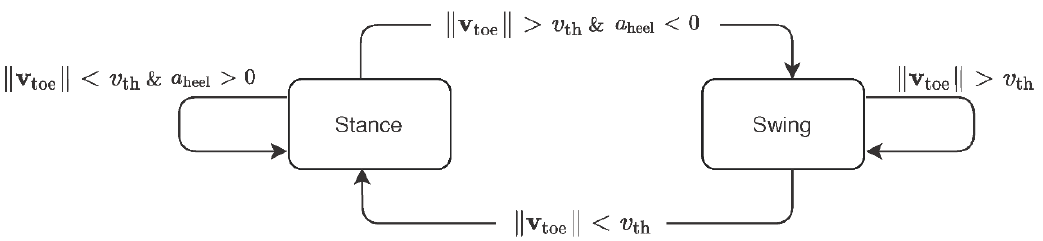
Figure 3. Ground contact detection algorithm.